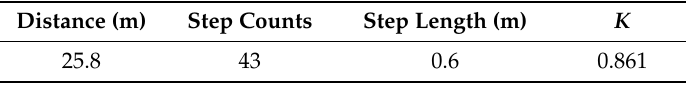
Table 2. K value and training